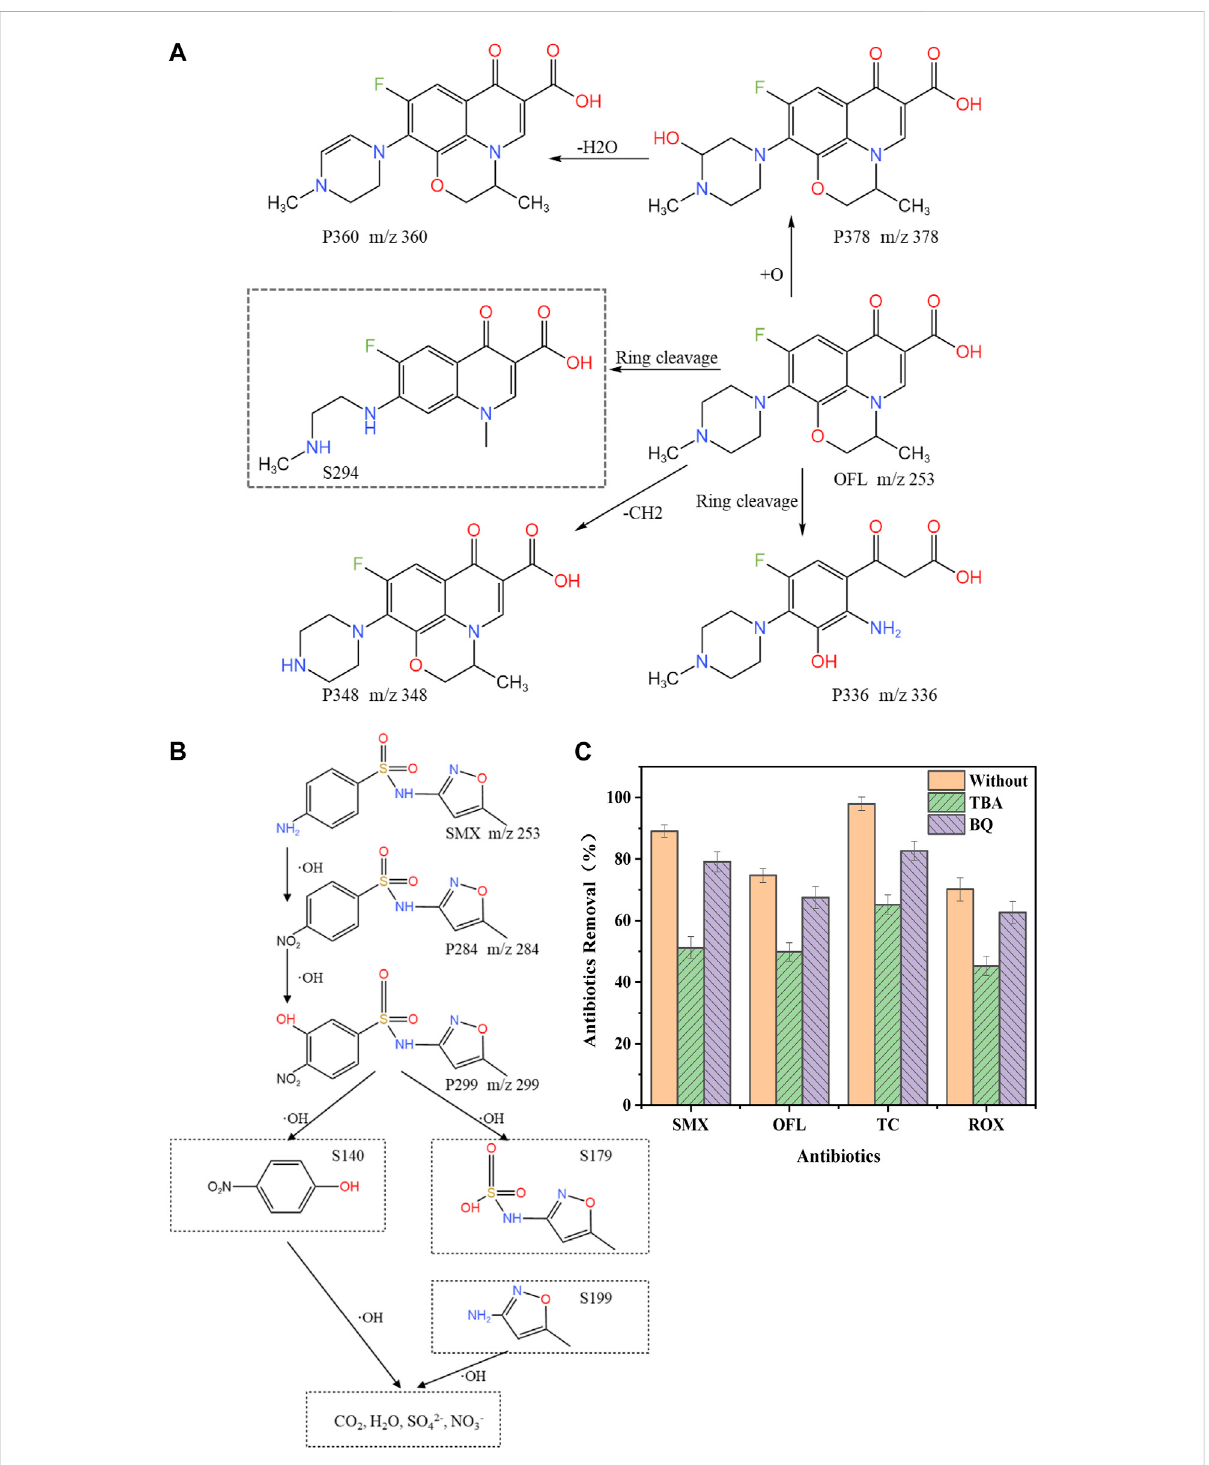
FIGURE 4 Proposed degradation pathway and mechanisms of antibiotics. (A) OFL (B) SMX (C) In fl uence of TBA and BQ on the electrochemical oxidation of